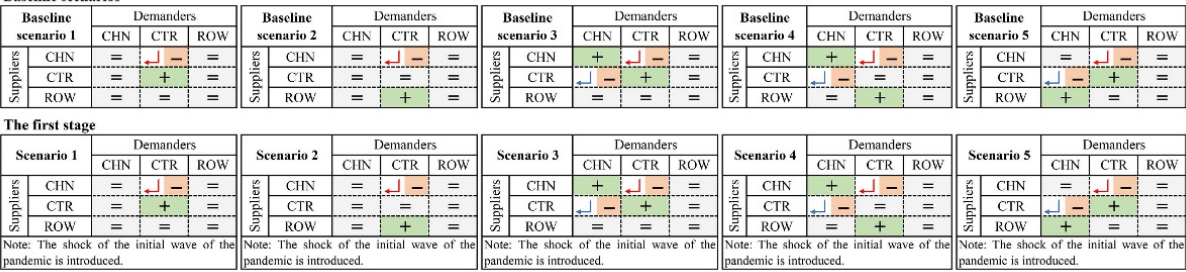
Figure 1. Design of baseline scenarios and scenarios for COVID-19. In terms of baseline scenarios, as shown in Figure 1, baseline scenarios 1 and 2 assume that CTR do not import from China and meet demand for China’s products by increasing internal production (baseline scenario 1) or imports from ROW (baseline scenario 2). Baseline scenarios 3–5 assume that CTR do not import from China, while China does not import from CTR. Specifically, baseline scenario 3 assumes that CTR demand for China’s products and China’s demand for CTR products could be met by their own products; baseline scenario 4 assumes that CTR demand is met by ROW products and China’s demand is met by domestic products; and baseline scenario 5 assumes that CTR demand is met by their own products and China’s demand is met by ROW products. At the first stage, China’s domestic outbreak may exacerbate trade protectionism. This means that the actual trade relations among regions at this stage may be closer to the extreme trade relations in the baseline scenarios. Therefore, this paper introduces the shock of the initial wave of the pandemic into the five baseline scenarios and defines them as scenarios 1–5, as shown in Figure 1. The trade relations in scenarios 1–5 correspond to those in baseline scenarios 1–5, respectively. At the second stage, the global spread of COVID-19 may further aggravate global trade protectionism. This paper introduces the shock of the second wave of the pandemic into baseline scenarios 3–5, and sets optimistic scenarios (scenarios 6–8) and pessimistic scenarios (scenarios 9–11) considering the uncertainty of the spread of the pandemic, as presented in Figure 1. The trade relations in scenarios 6–8 and scenarios 9–11 correspond to those in baseline scenarios 3–5, respectively. Overall, we set 11 scenarios to simulate the shock of COVID-19 in the context of trade protectionism. Scenarios 1–5 at the first stage and scenarios 6–11 at the second stage are used to simulate the impacts of the pandemic in China and the global spread of COVID- 19 in the context of trade protectionism, respectively.